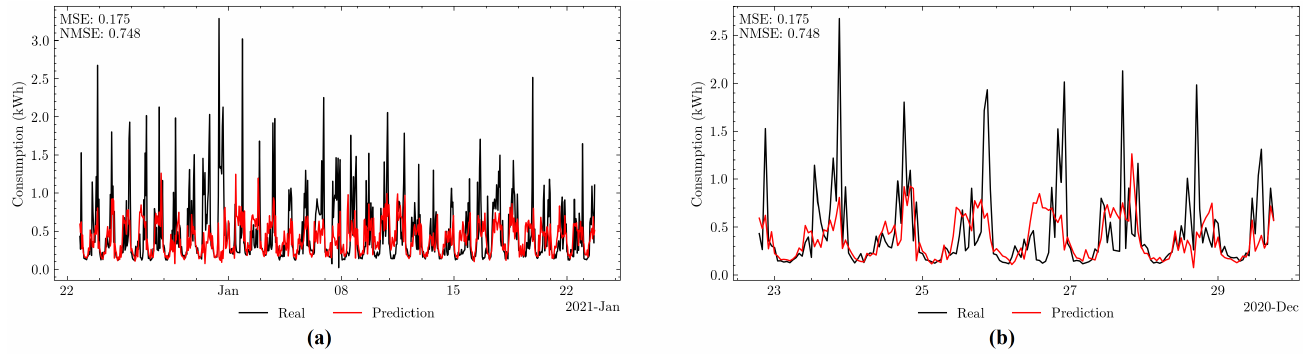
Figure 9. ( a ) Prediction (red) and actual value (black) of energy consumption for the months of December 2020 and January 2021. ( b ) Zoom in on the first week of the test